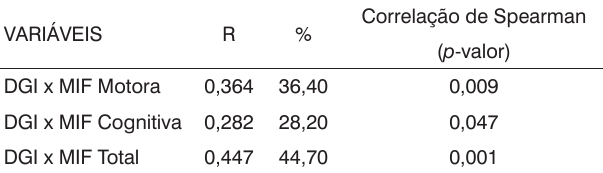
Tabela 1. Análise de correlação entre MIF Motora, MIF Cog- nitiva e MIF Total e DGI Total de 50 idosos com disfunções vestibulares periféricas crônicas.